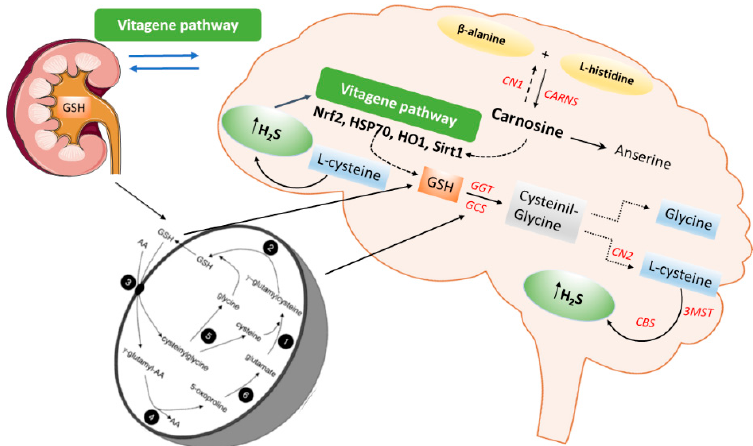
Figure 4. Schematic representation of the carnosine, glutathione, and hydrogen sulfide (H 2 S) pathways in the kidney-brain axis. γ -glutamyl transpeptidase (GGT) (3), γ -glutamyl cyclotransferase (4), dipeptidase (5), oxoprolinase (6), γ -glutamyl-cysteine synthase (1), and glutathione synthetase (2) operate in the Meister cycle to generate glutathione (GSH) and internalize amino acids (AA). GSH interacts with Cystathionine- β -synthase (CBS) and 3-mercaptopyruvate sulfurtransferase (3MST) to produce H 2